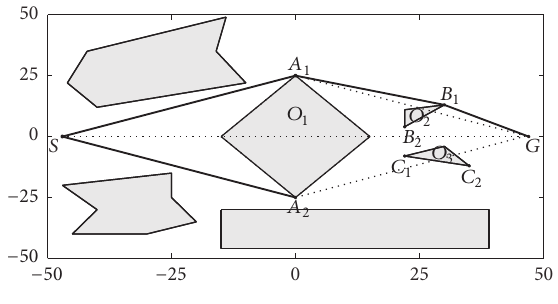
Figure 2: Unidirectional